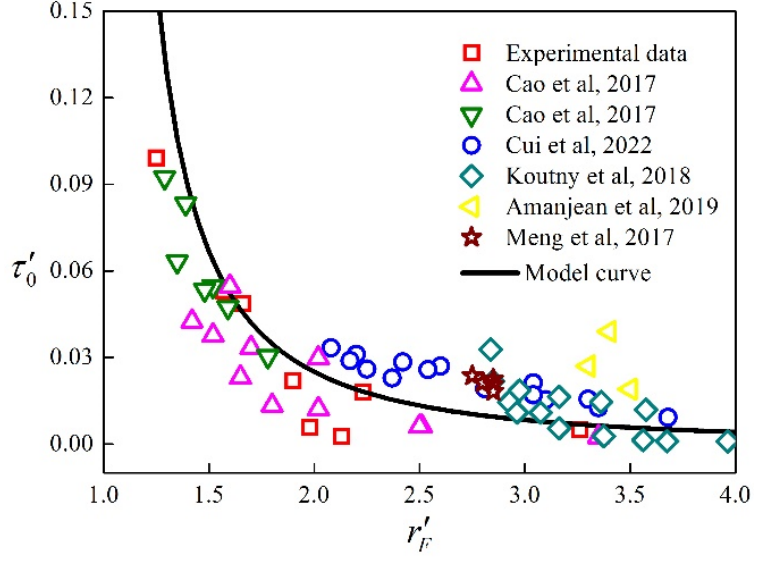
Figure 11. Comparison between dimensionless model curve and experiment data [12,26,33–36].